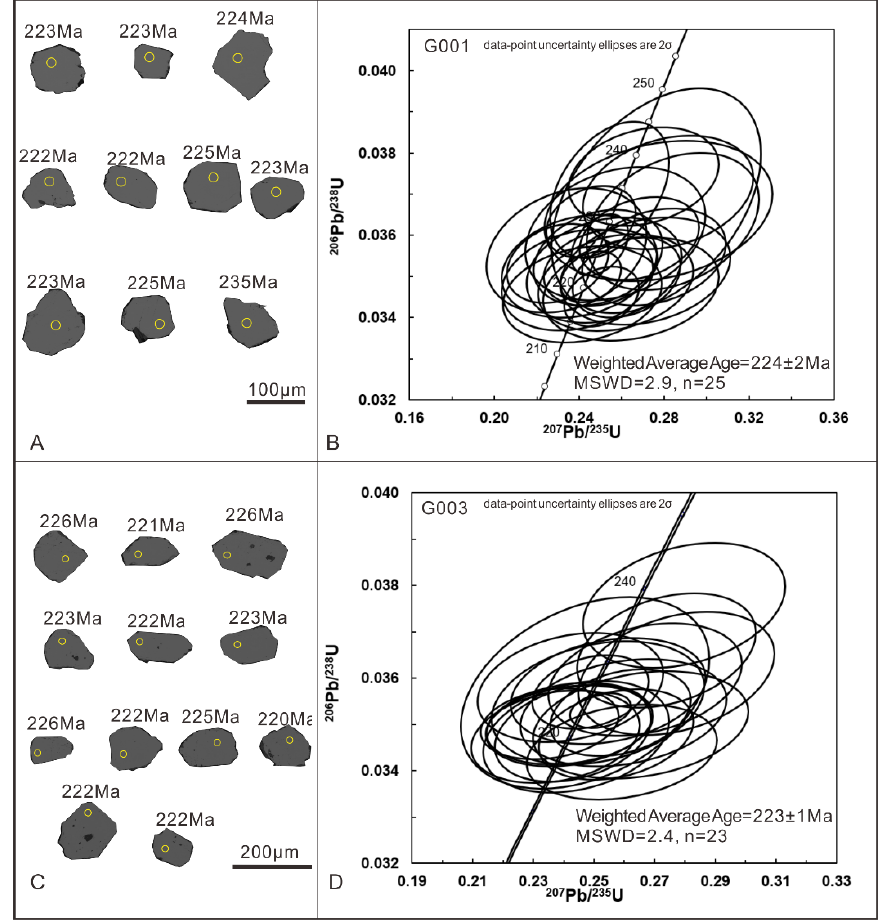
Figure 6. Typical BSE images ( A , C ) and LA-ICP-MS monazite U-Pb concordant curves ( B , D ) of monazite of Baishi granite. The yellow, solid-line circle represents the locations for monazite U-Pb. Table 3. LA-ICP-MS monazite rare earth elements data of Baishi granite (×10 − 6 ). Twenty-five spot analyses of sample G001 yielded a weighted mean 206 U/ 238 Pb age of 224 ± 2 Ma (MSWD = 2.9) (Figure 6B). Twenty-three spot analyses of sample G003 yielded a weighted mean 206 U/ 238 Pb age of 223 ± 1 Ma (MSWD = 5.2) (Figure 6D). The ages were interpreted as the crystallization